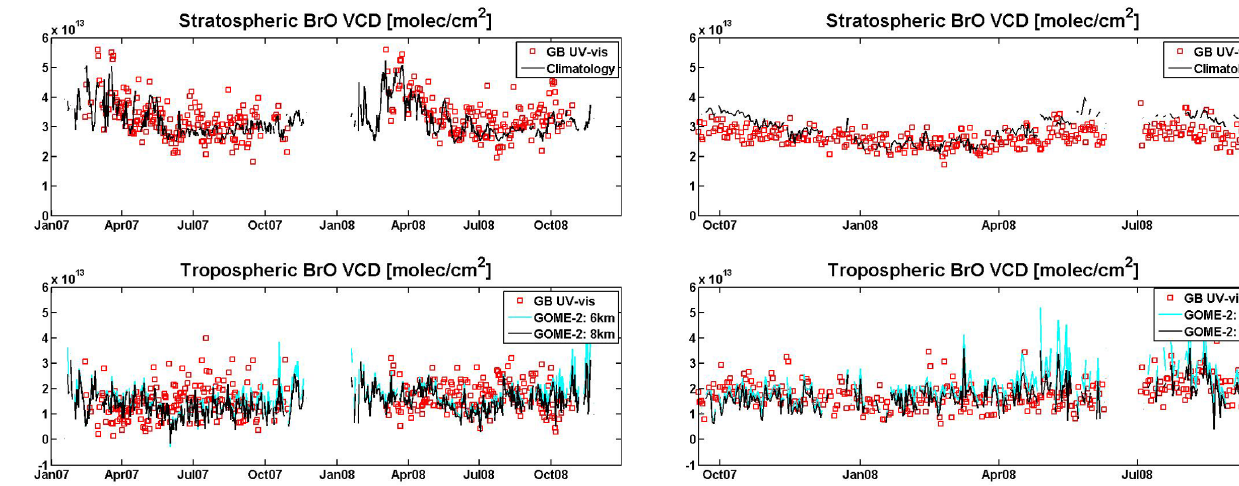
Fig. 7. Same as Fig. 6, at Lauder for the period September 2007– October